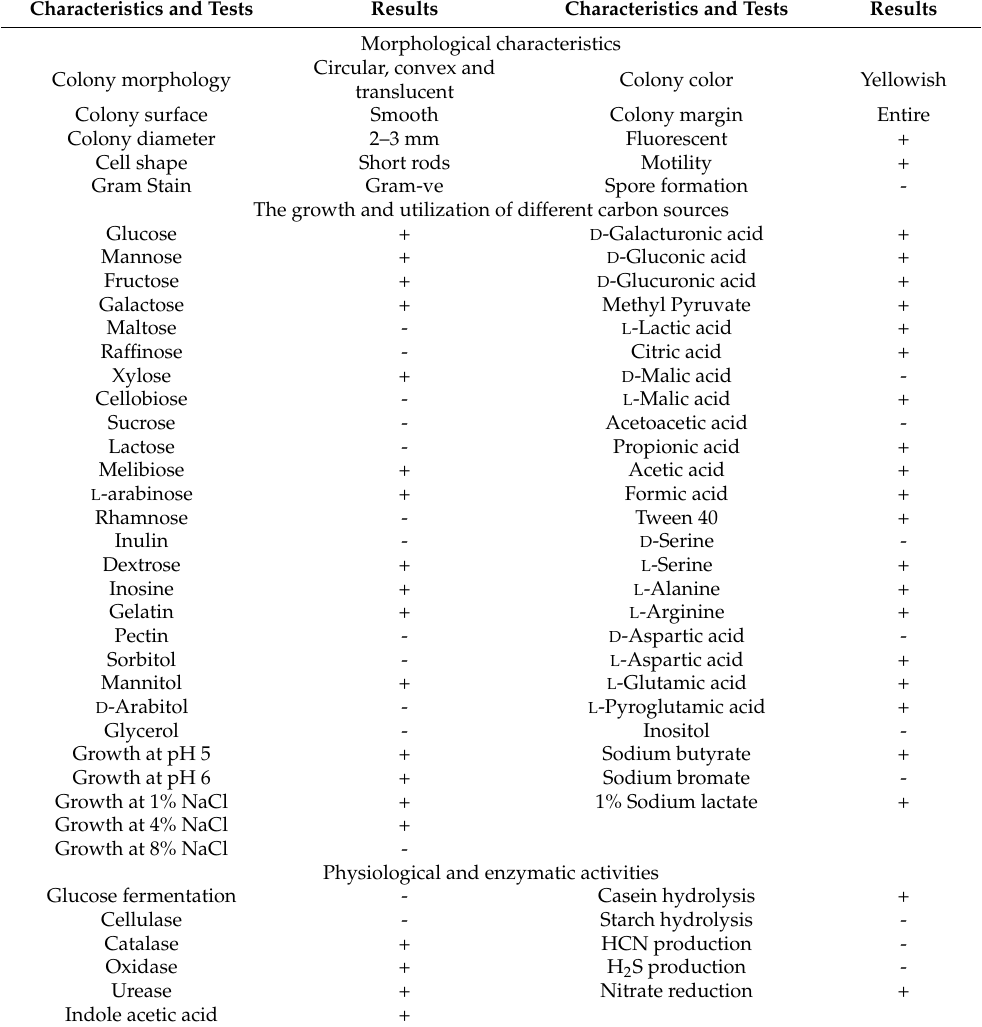
Table 1. Morphological characteristics, physiological, and biochemical tests for characterization and identification of the endophytic bacterium Pseudomonas putida strain ASU15